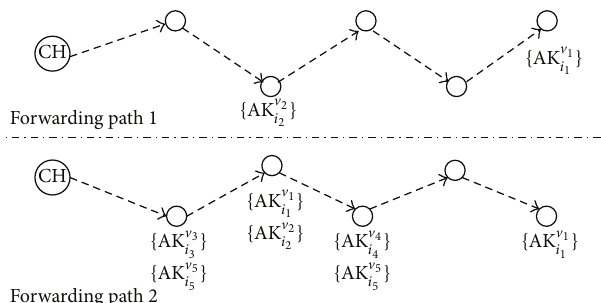
Figure 2: Effects of the forwarding path of a key dissemination